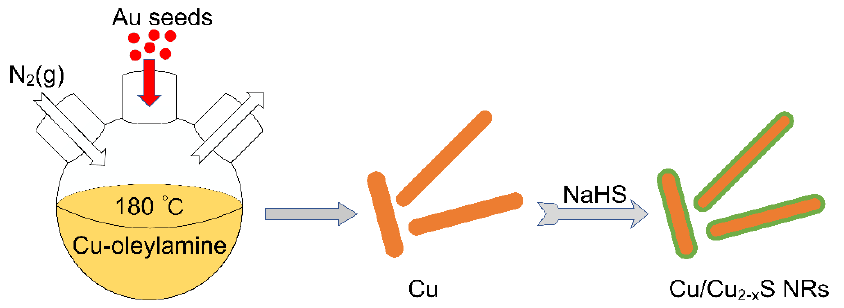
Figure 1. Scheme of seed-mediated growth of Cu NRs and subsequent sulfidation.